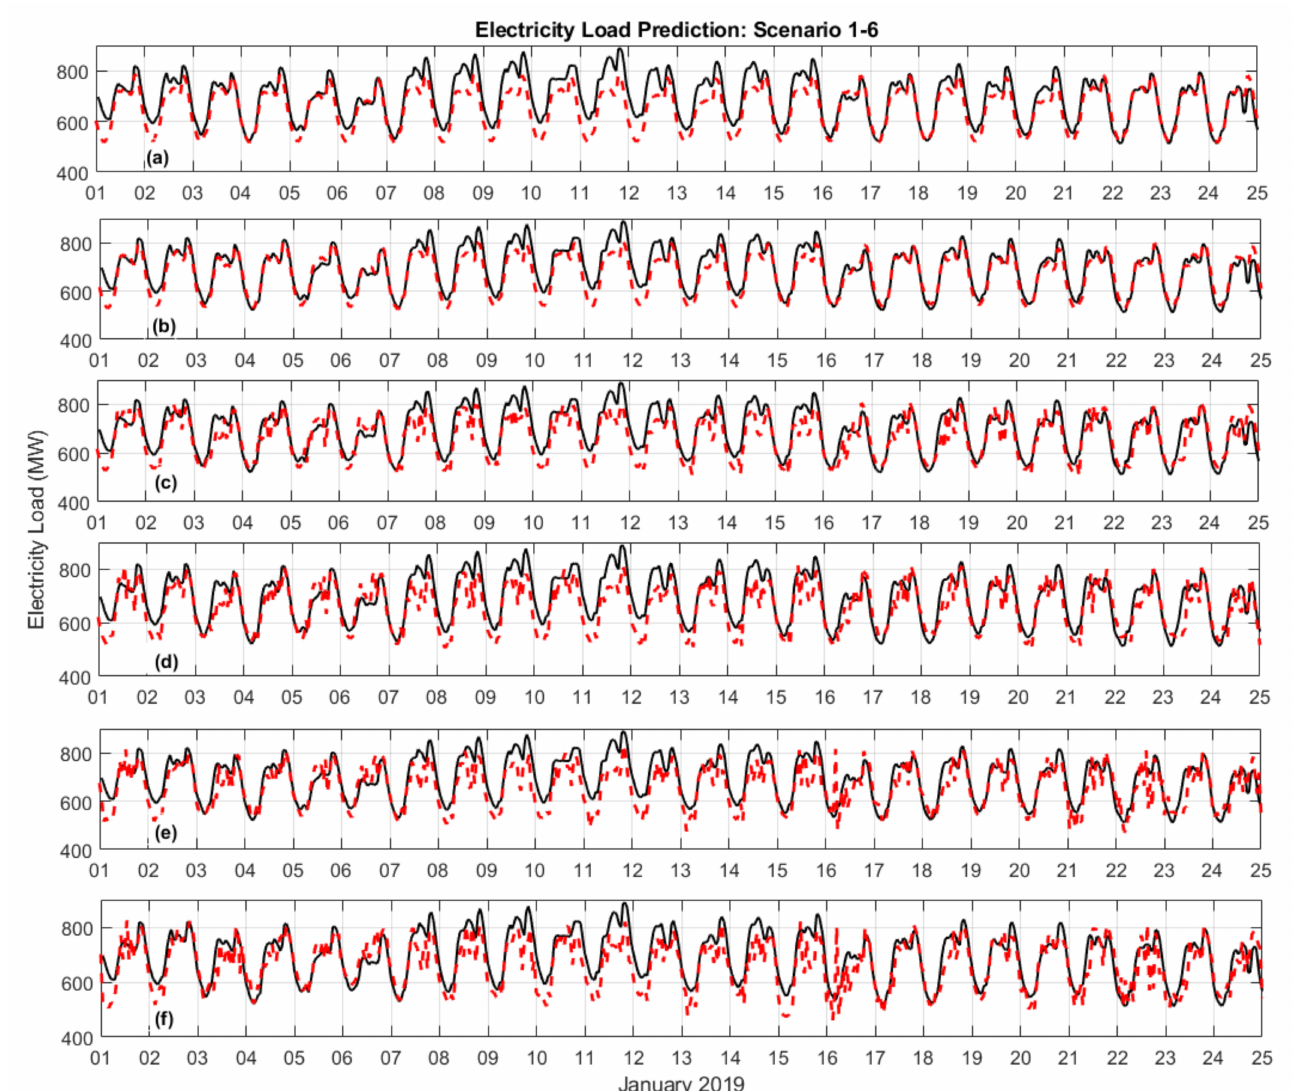
Figure 8. Comparison between electricity load data (solid black line) during the period 1–25 January 2019, with results of prediction by using GRNN model (dashed red line) with various feature scenarios; ( a ) scenario-1; ( b ) scenario-2; ( c ) scenario-3; ( d ) scenario-4; ( e ) scenario-5; and ( f )